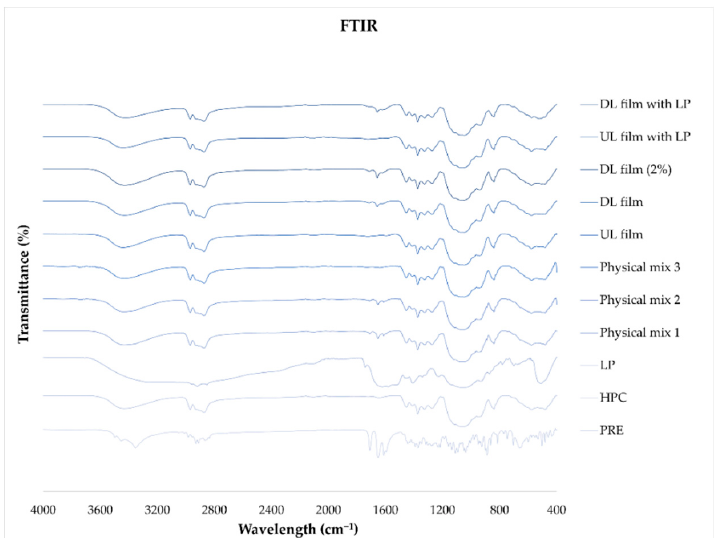
Figure 11. FTIR spectra of pure substances, physical mixtures, and unloaded and drug-loaded films with and without liver powder. Physical mixture 1 is a mixture of prednisolone and hydroxypropyl cellulose, physical mixture 2 contains all three dry substances (prednisolone, hydroxypropyl